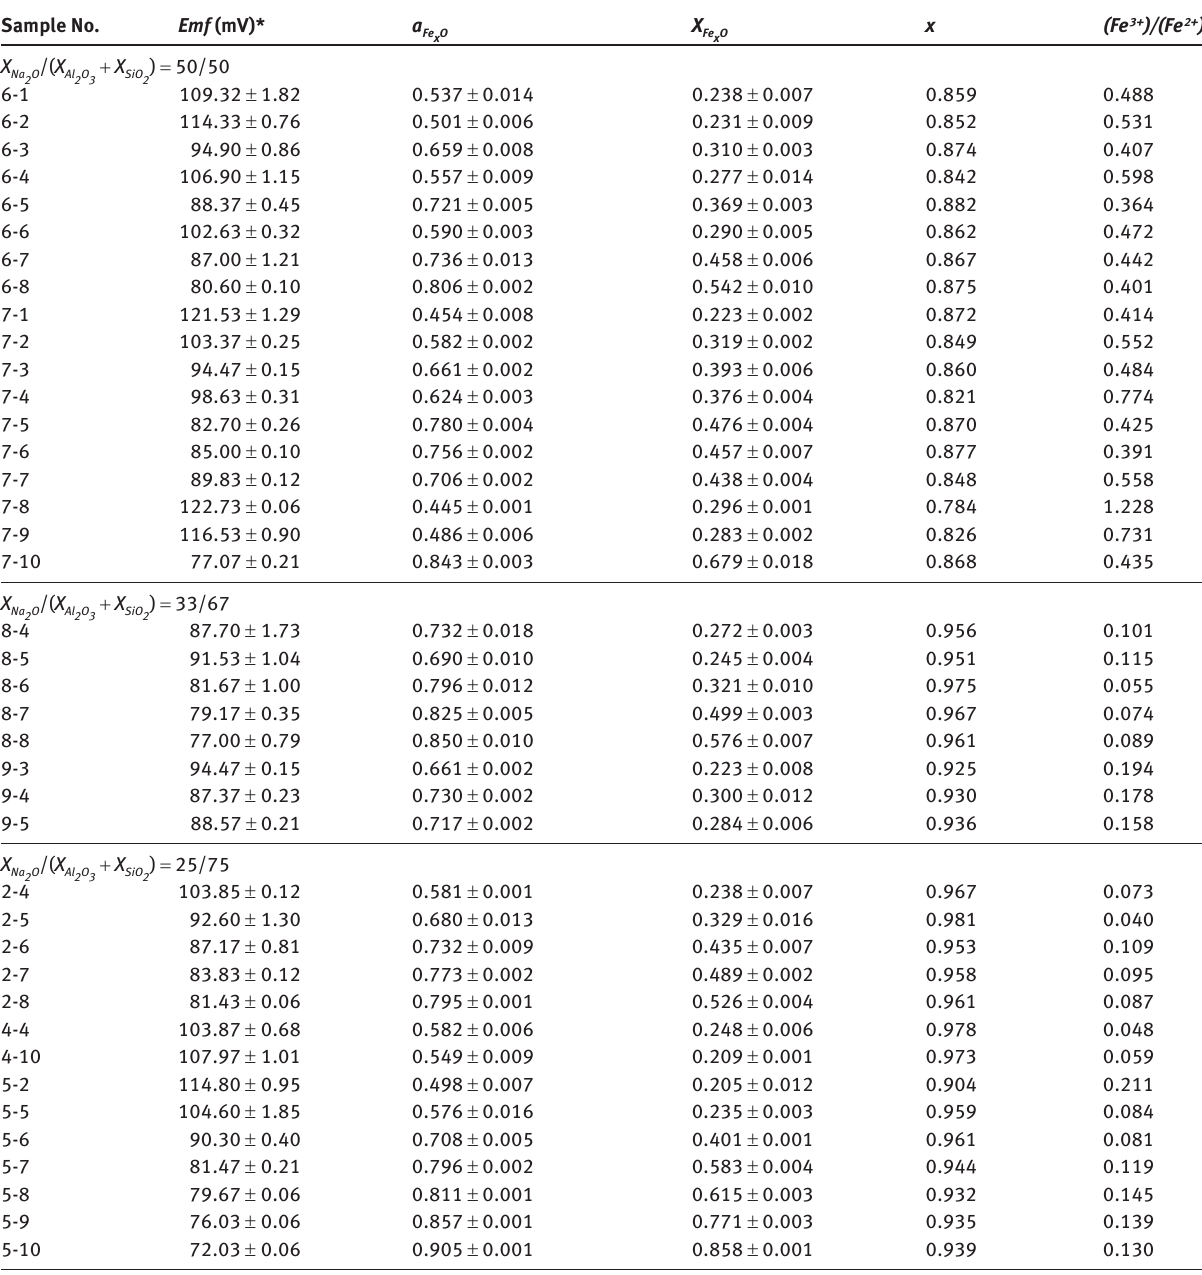
Table 1: Experimental results at 1673